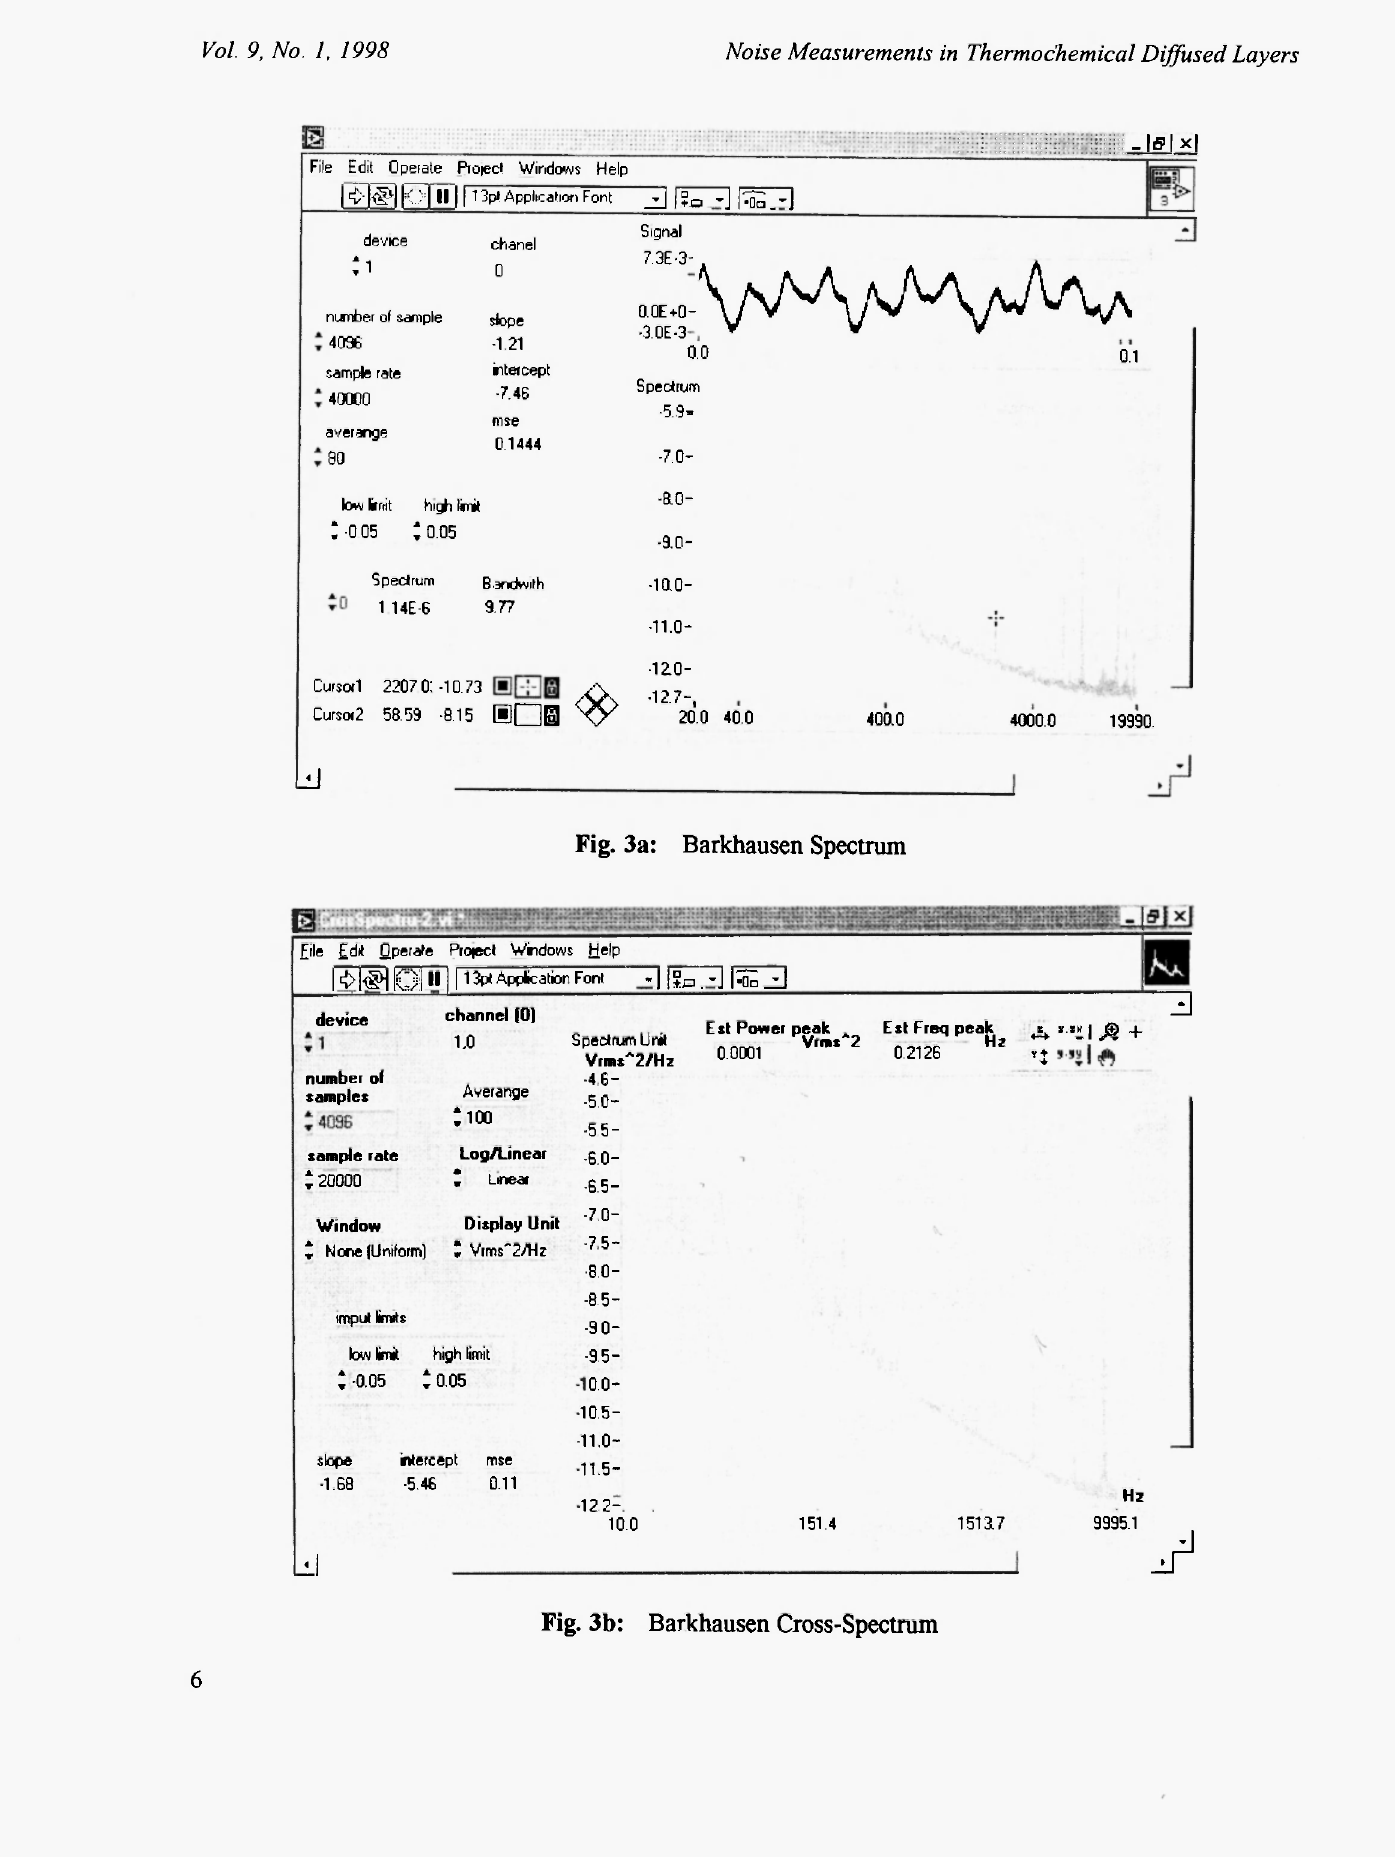
Fig. 3a: Barkhausen Spectrum